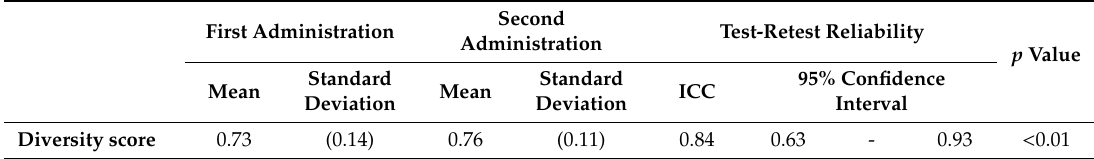
Table 1. Intraclass correlation coe ffi cients (ICC) of the Activity Diversity